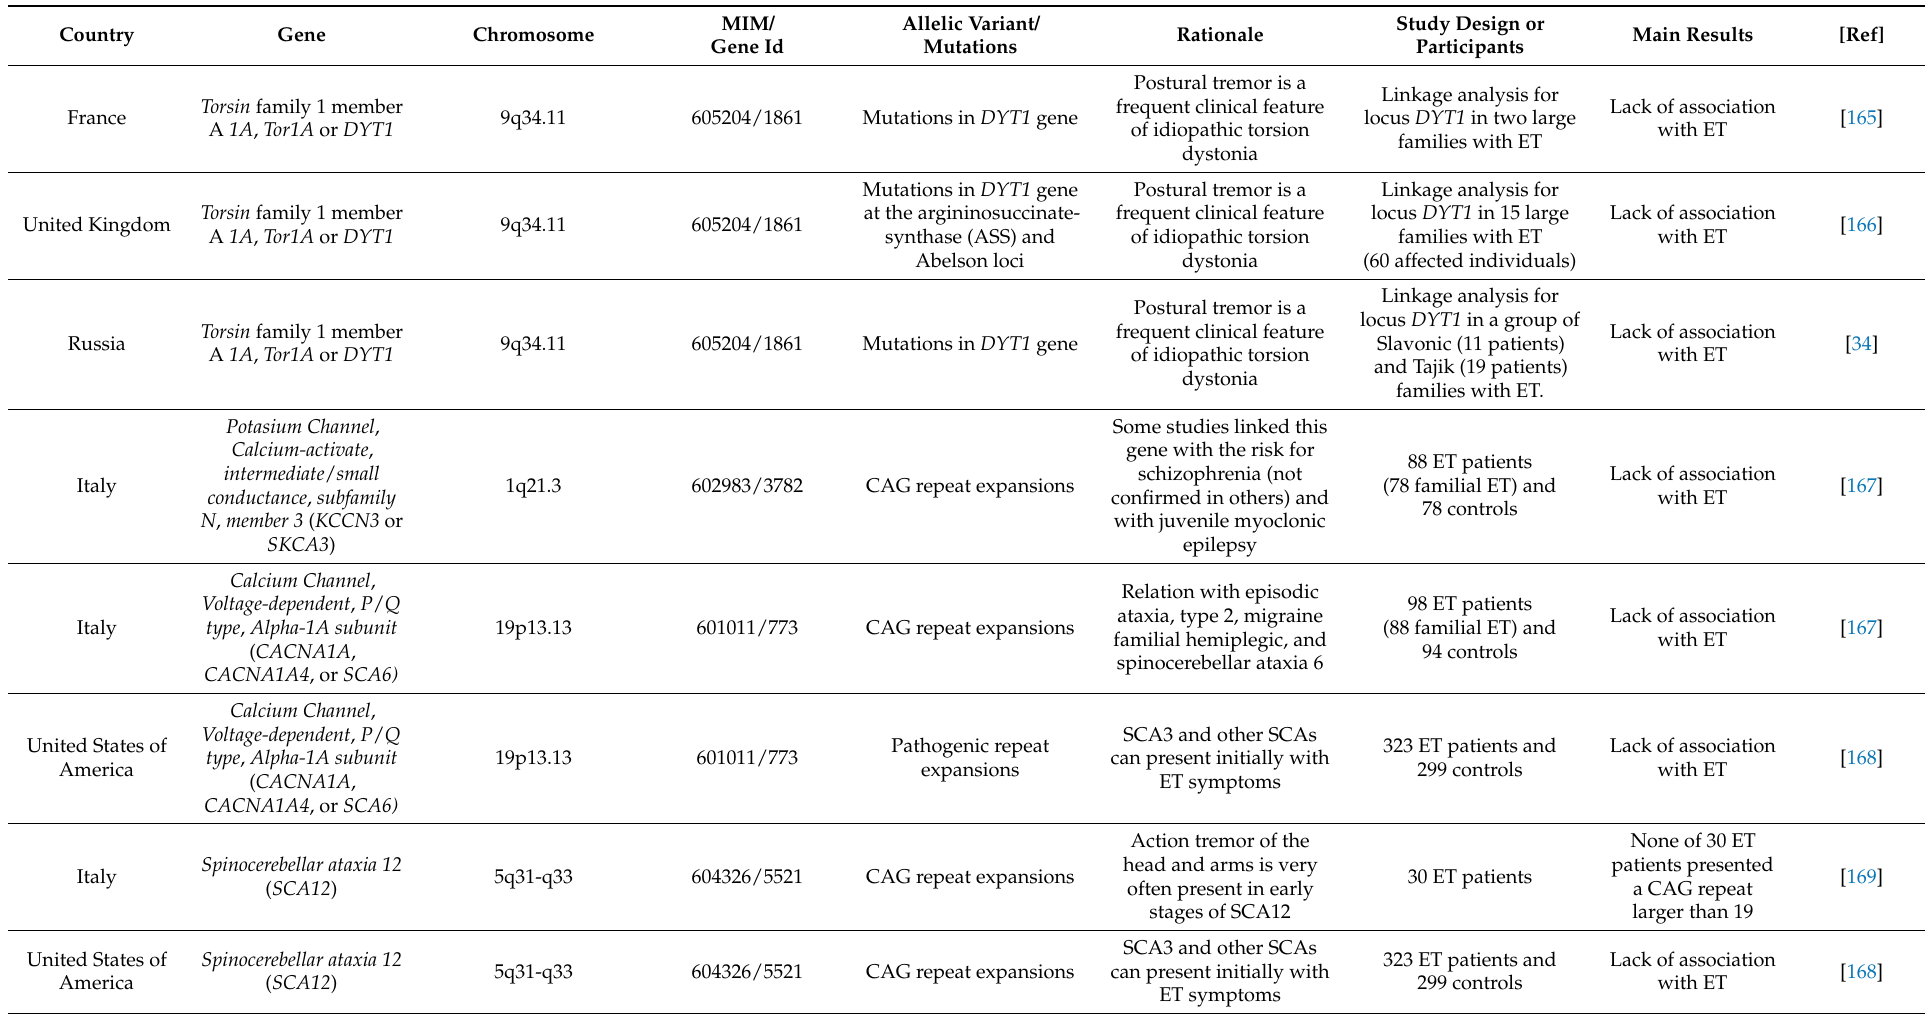
Table 3. Data from other studies of possible candidate genes for